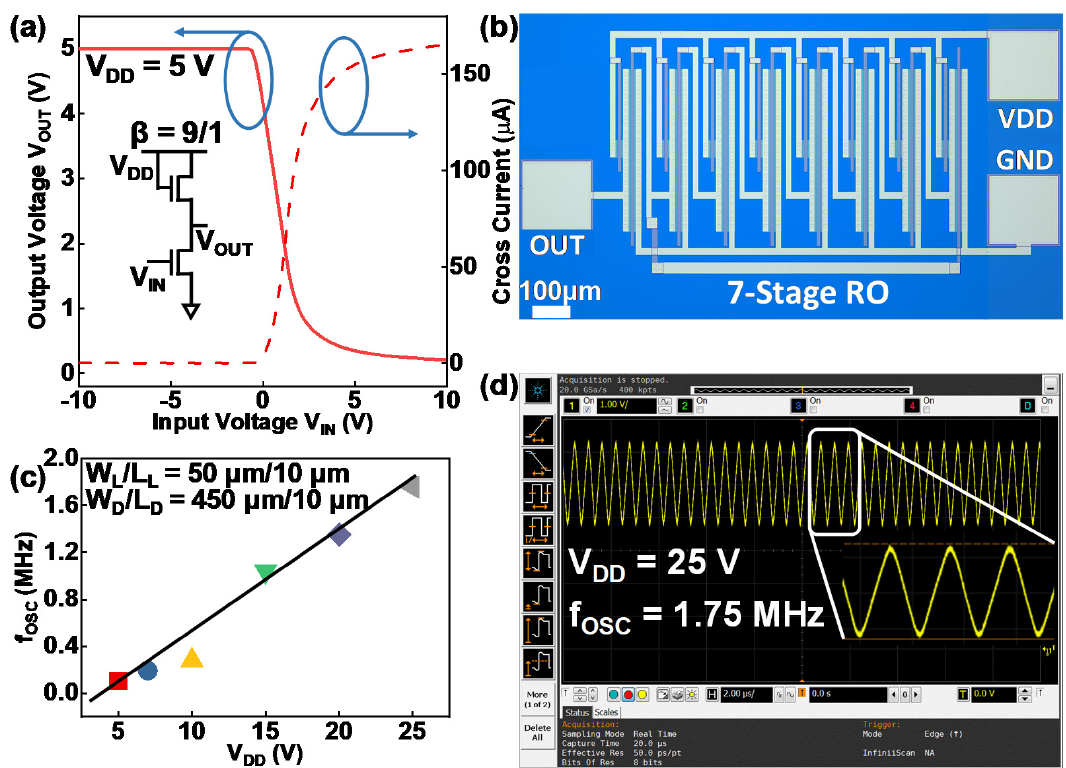
Figure 4. ( a ) VTC, cross current, and schematic of the inverter with a β of 9/1 at V DD = 5 V. ( b ) Optical microscope image of the fabricated 7-stage RO. ( c ) RO frequency under different V DD . ( d ) RO output at V DD = 25 V measured by an oscilloscope.